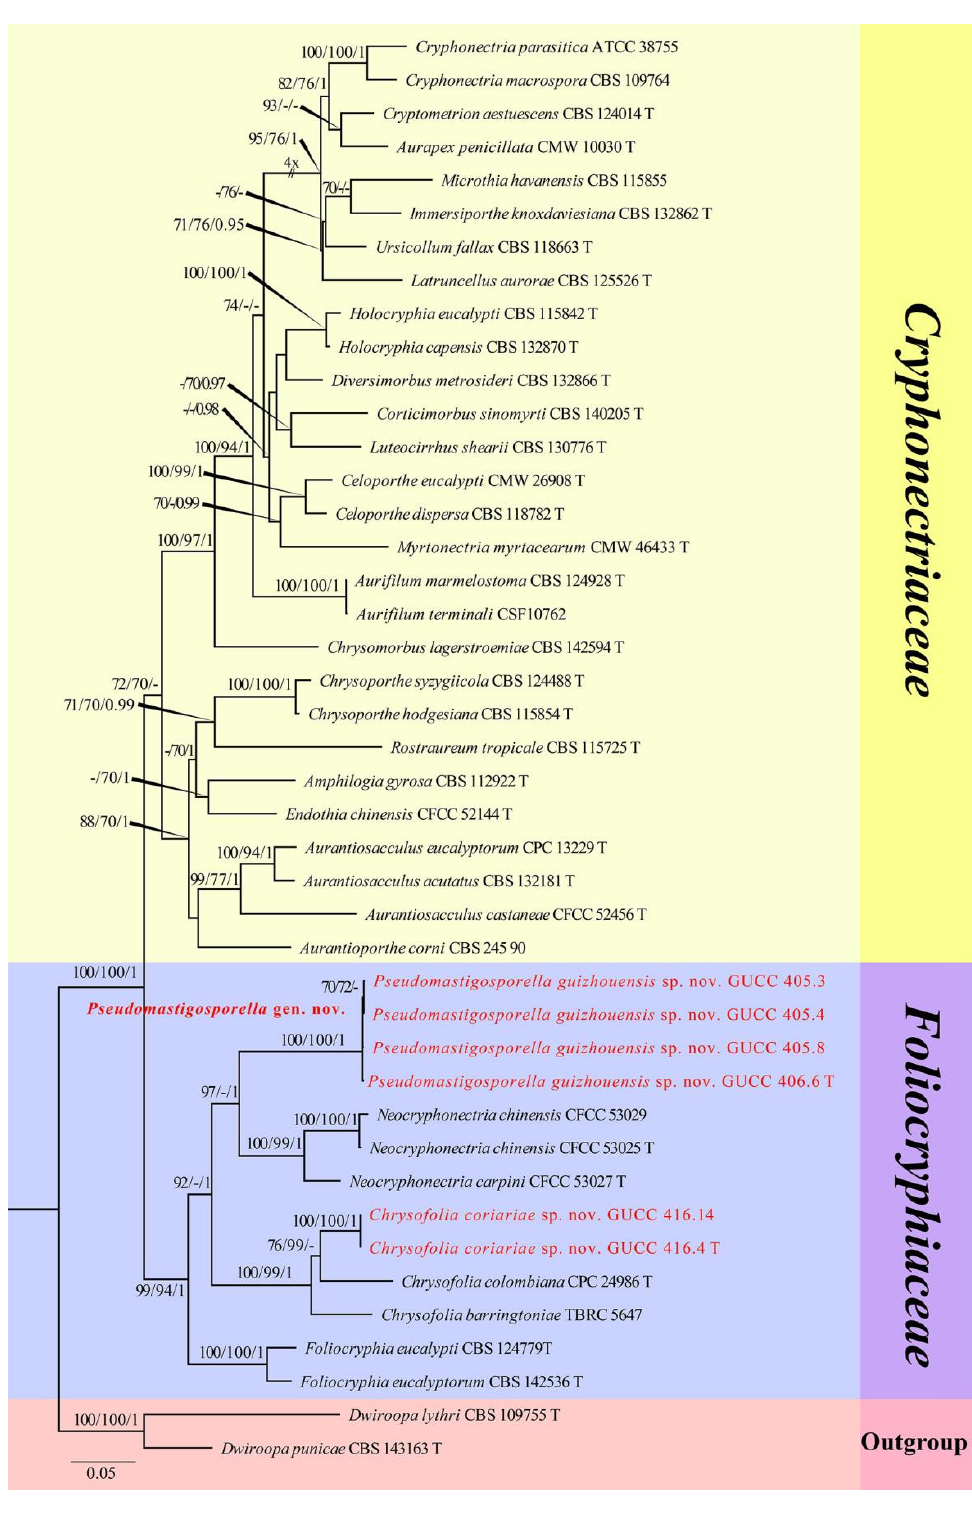
Figure 1. Phylogram generated from RAxML analysis of a concatenated ITS-LSU- rpb2 - tef1 - tub2 sequence dataset to represent the phylogenetic relationships of taxa in Foliocryphiaceae and Cryphonectriaceae . The tree was rooted with Dwiroopa lythri (CBS 109755, ex-type strain) and Dw. punicae (CBS 143163, ex-type strain). Bootstrap support values for ML and MP equal to or greater than 70% and Bayesian posterior probabilities equal to or higher than 0.95 PP are indicated above the nodes as ML/MP/PP. Support values lower than 70% ML/MP and 0.95 PP are indicated by a hyphen (-). The newly generated sequences are indicated in red.